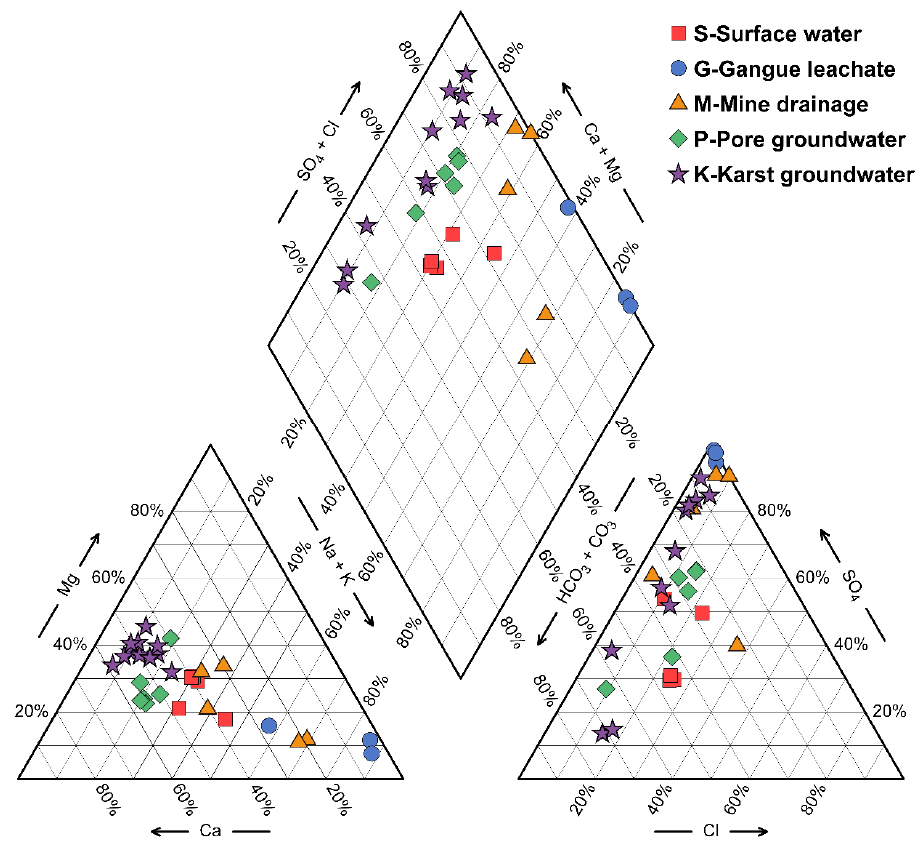
Figure 3. Distribution and hydrochemical characteristics of different types of water